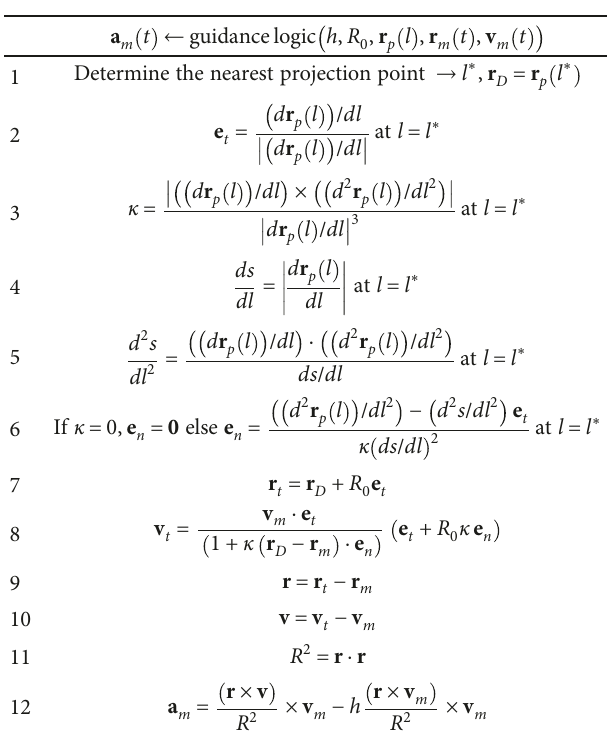
Table 1: Summary of the proposed guidance